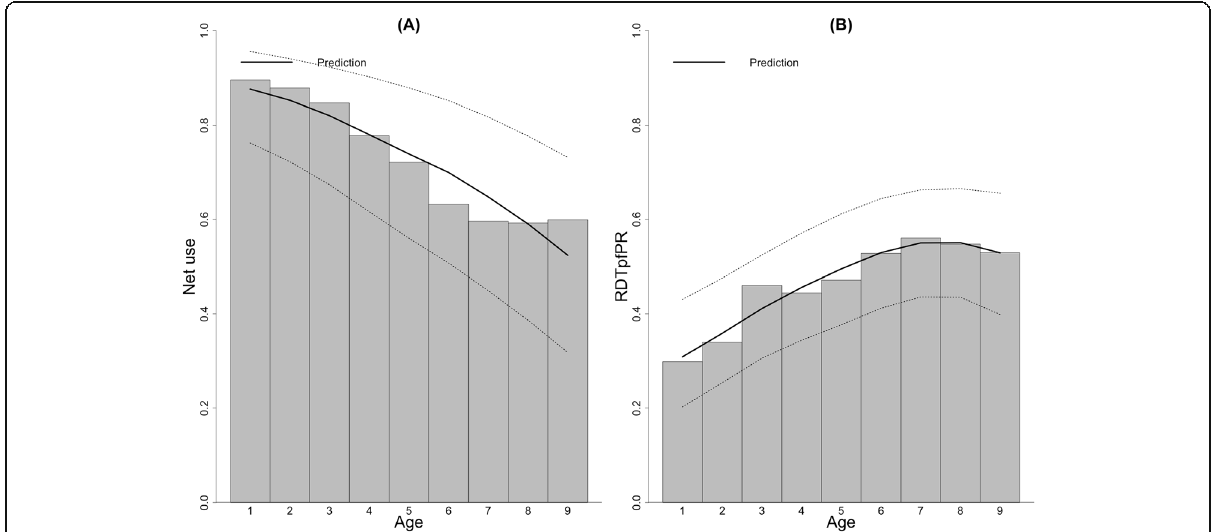
Fig. 5 The relationships of age with RDTpfPR and net